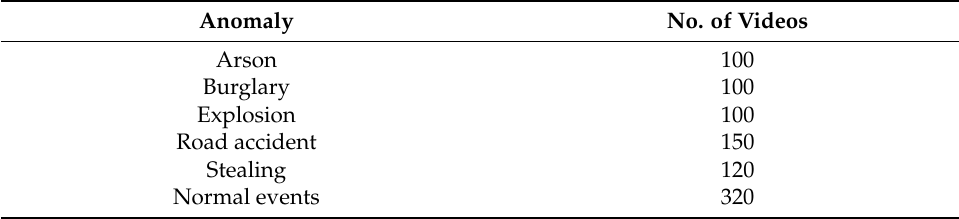
Figure 11. Sampling images with Crimes-mini dataset. Table 4. Number of videos of each anomaly in our dataset.